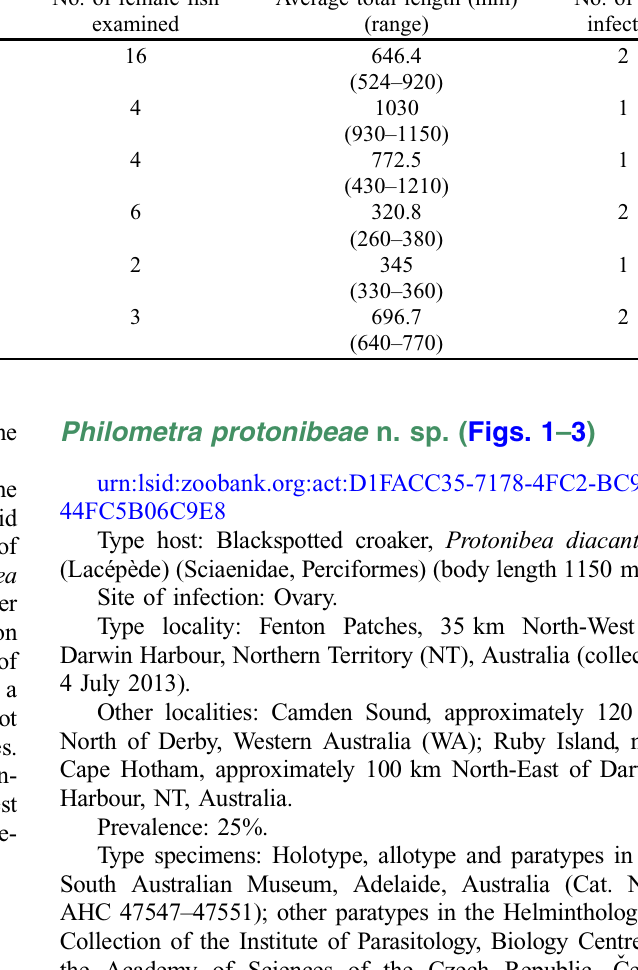
Table 1. Collection localities, no. of female fish, average total length and number of infected fish examined. Fish Species